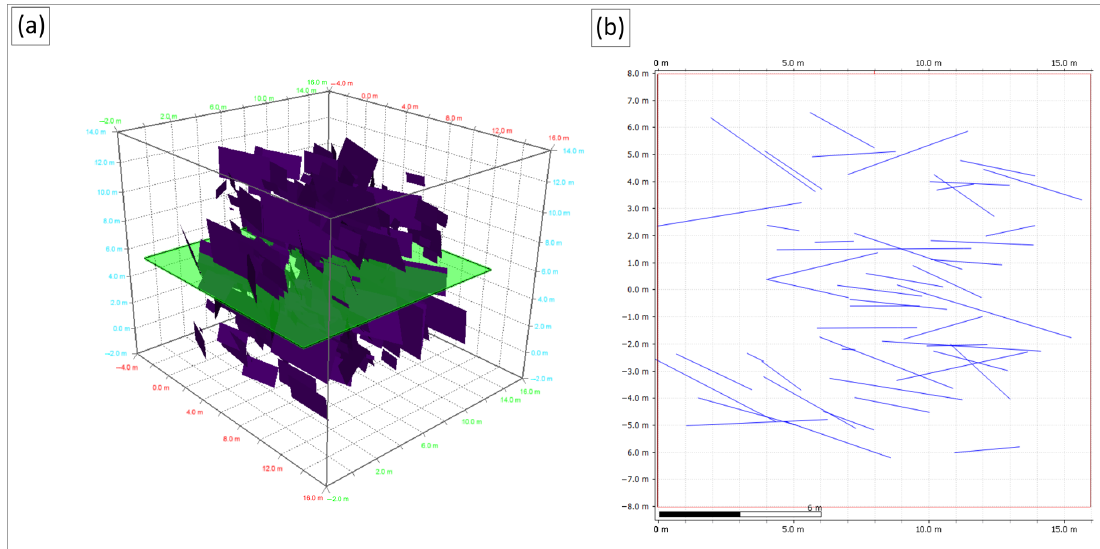
Figure 3. ( a ) 2D pseudo-scanline creation (in green) in the initial Discrete Fracture Network model; ( b ) pseudo-scanlines extracted from the DFN and used to calculate P 21.